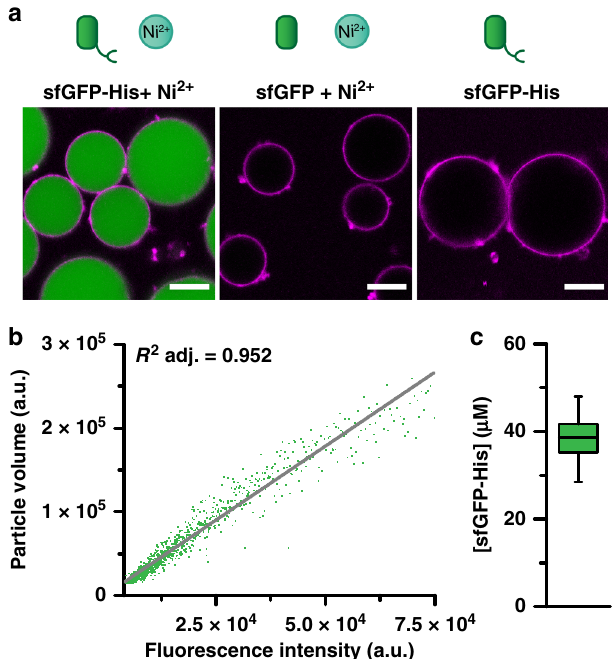
Fig. 2 Controlled, homogeneous uptake of sfGFP-His into NTA- functionalized protocells. a False-colored confocal micrographs of protocells show the speci fi c uptake of sfGFP-His (green) by Ni-NTA-Am. The membrane is stained with Nile Red (purple), scale bar: 10 µ m. Uncropped images are to be found in Supplementary Fig. 7. b Flow cytometry analysis of sfGFP-His loaded protocells. For clarity of the graph, a 10th of all data points collected is shown. Gating parameters and population statistics are reported in Supplementary Fig. 8. c Box plot analysis of the measured concentration of sfGFP-His measured inside the coacervate interior with confocal microscopy. Reference curve Supplementary Fig. 9. n =